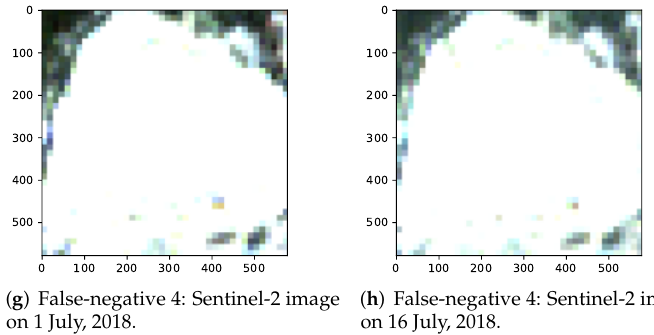
Figure 22. Visualization of four of the false-negative blobs incorrectly classified by the best